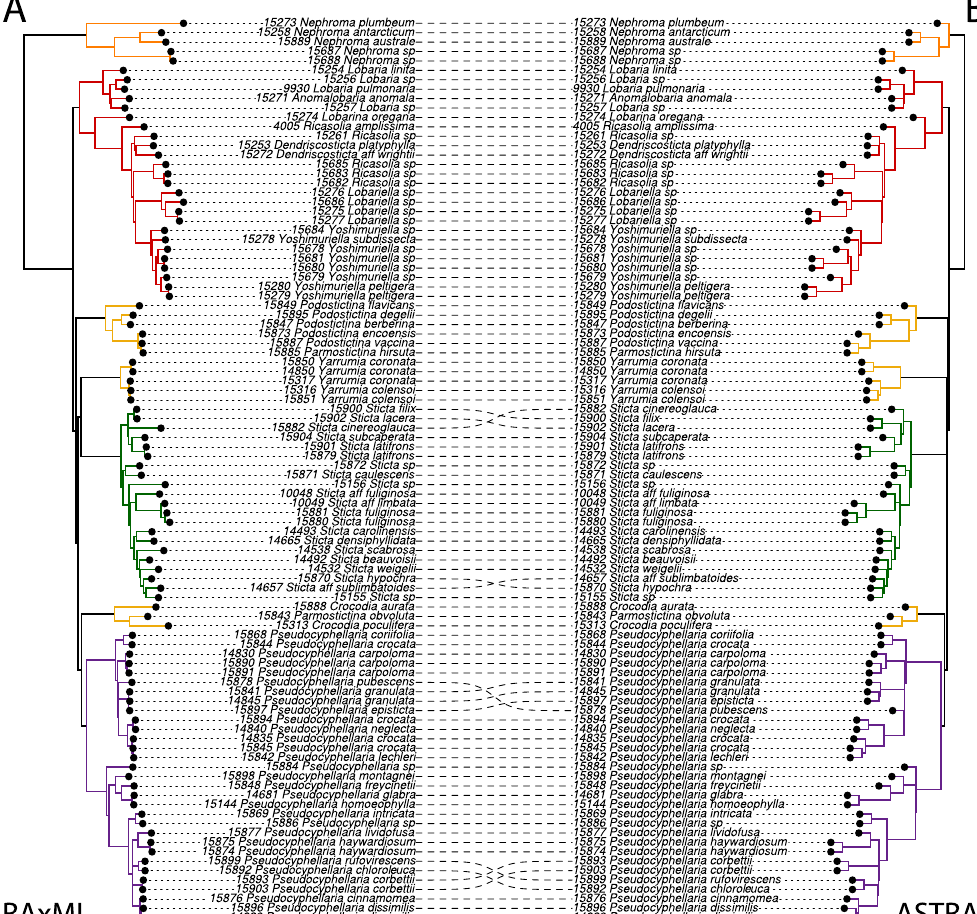
Figure 2. Congruence of topologies inferred with concatenation ( A : RAxML) and species tree approaches ( B : ASTRAL) from dataset composed of 376 amino acid sequences. The colors of branches are assigned to clades as follows: Orange: Nephroma (outgroup); Red: Anomolobaria , Dendriscosticta , Lobaria , Lobariella , Lobarina , Ricasolia , Yoshimuriella ; Yellow: Crocodia , Parmostictina , Podostictina , and Yarrumia ; Green: Sticta ; Purple: Pseudocyphellaria